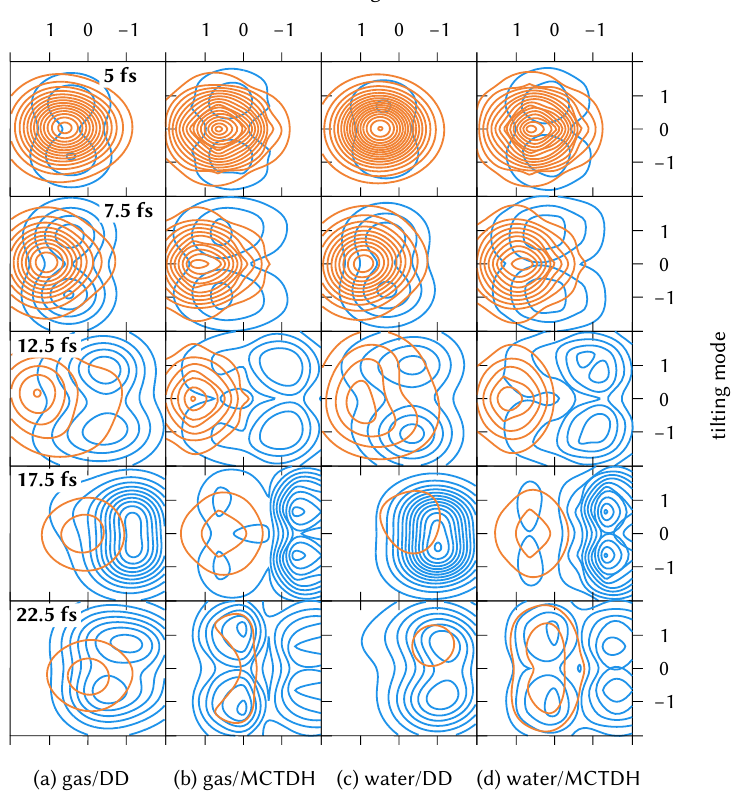
Figure 8. Comparison of the time evolution of the diabatic reduced density (orange on the L a state and blue on the L b ) along the C=C stretching (q46 for the gas phase case and q60 for the water cluster) and the tilting mode that shows the largest coupling (q45 and q57, respectively) for the 4-mode DD-vMCG and MCTDH dynamics on the LVC